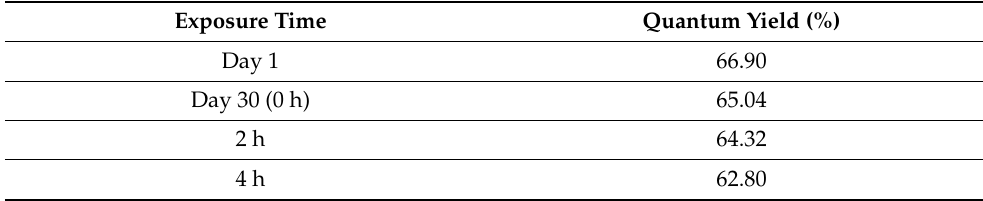
Figure 6. Spin speed-dependent thickness and quantum yield ( a ) 2500–4000 RPM, ( b ) 2500–5000, ( c ) 2500–6000, and ( d ) 2500–7000. Table 4. Photostability of the fluorescent film under UV